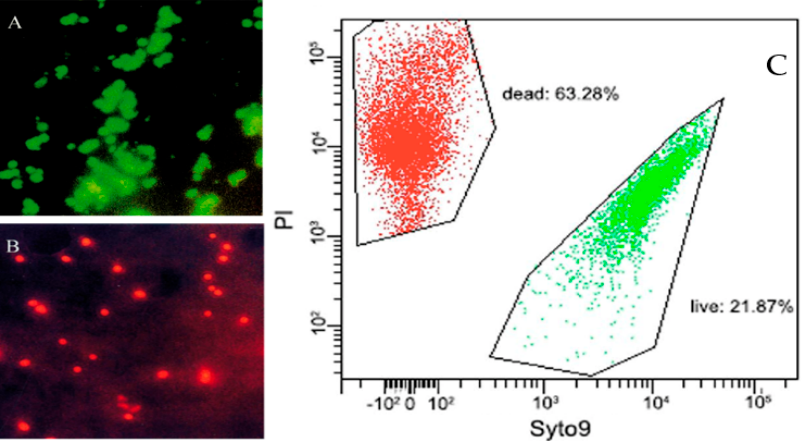
Figure 4. Fluorescence microscopy of viable ( A ) and dead ( B ) V. cholerae [68]. VBNC cells adapted from the flow cytometry analysis of VBNC cells ( C ) induced by low temperature storage in beer, adapted from [78]. Live cells (green fluorescence, SYTO 9 ® ) and dead cells (red fluorescence, PI) are viewed simultaneously by appropriate excitation and emission spectra.